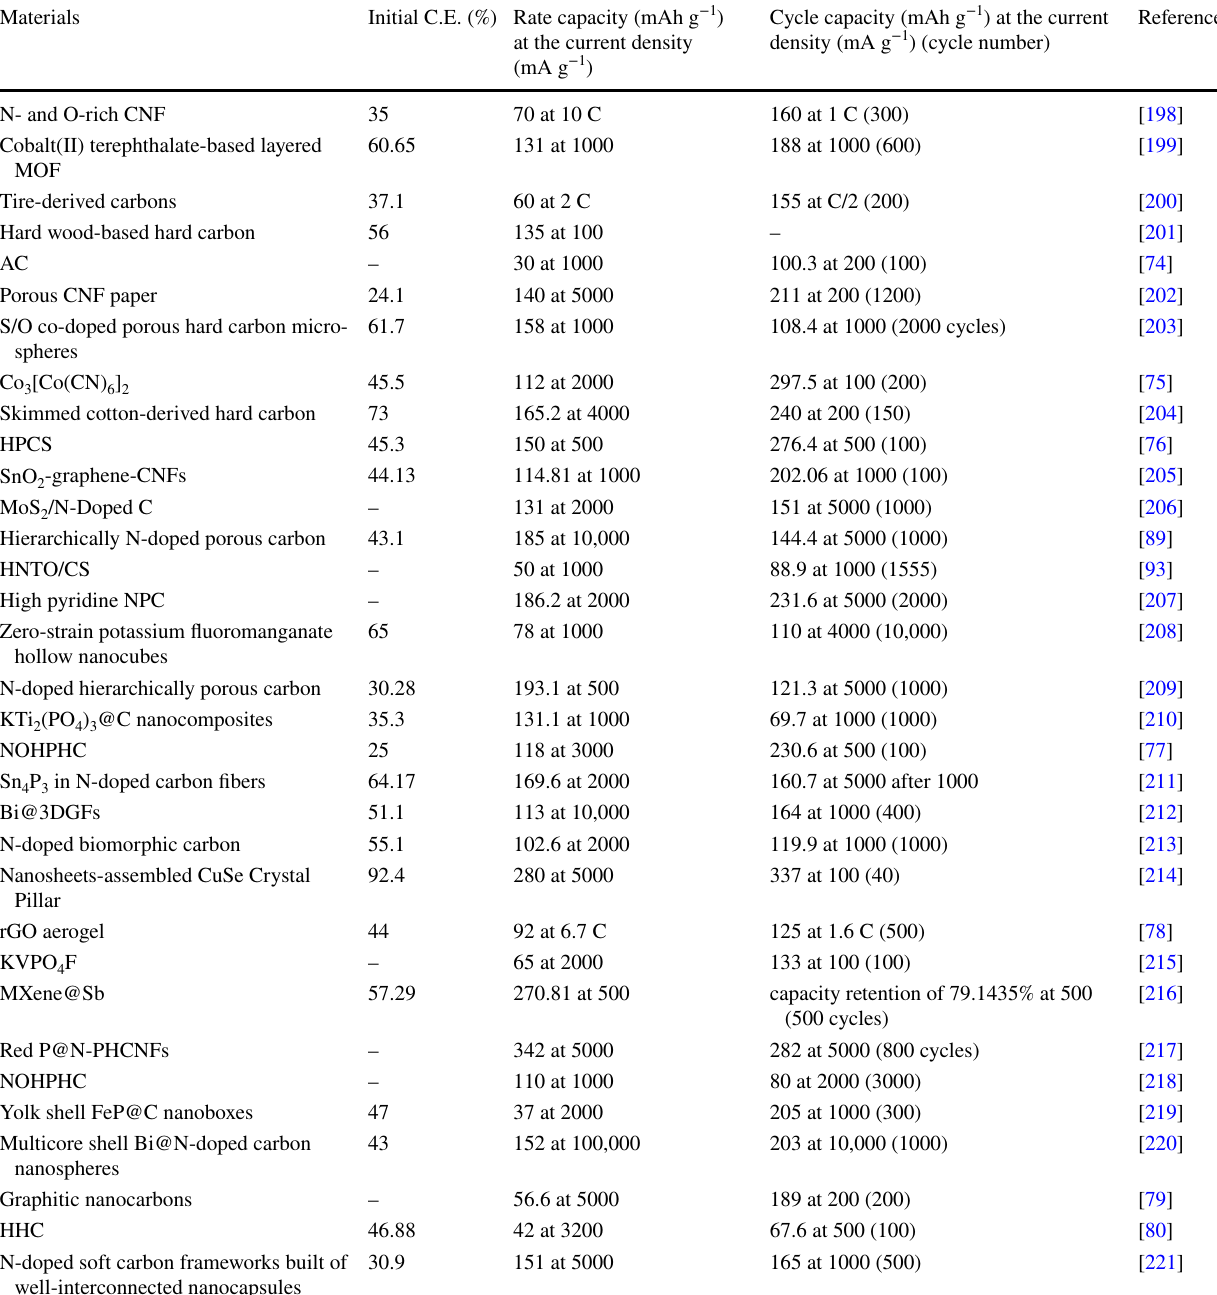
Table 4 Comparison of the state-of-the-art performances of 3D anode materials in PIBs